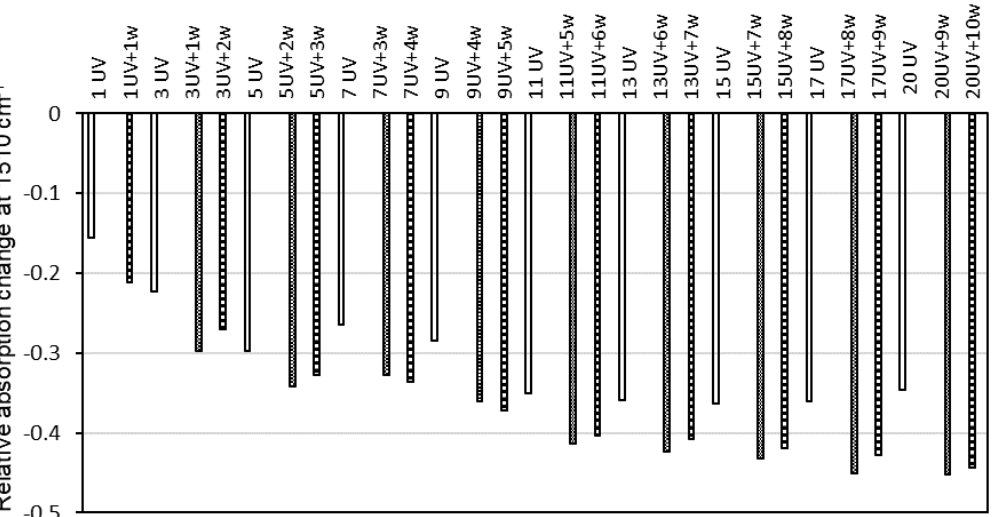
Figure 7. Absorption change of guaiacyl lignin in spruce at 1510 cm − 1 . Empty columns show the effect of pure UV irradiation. xUV = x-day UV irradiation; xUV + yw is an abbreviation where x is the extent of UV irradiation, and y is the extent of water leaching in days.